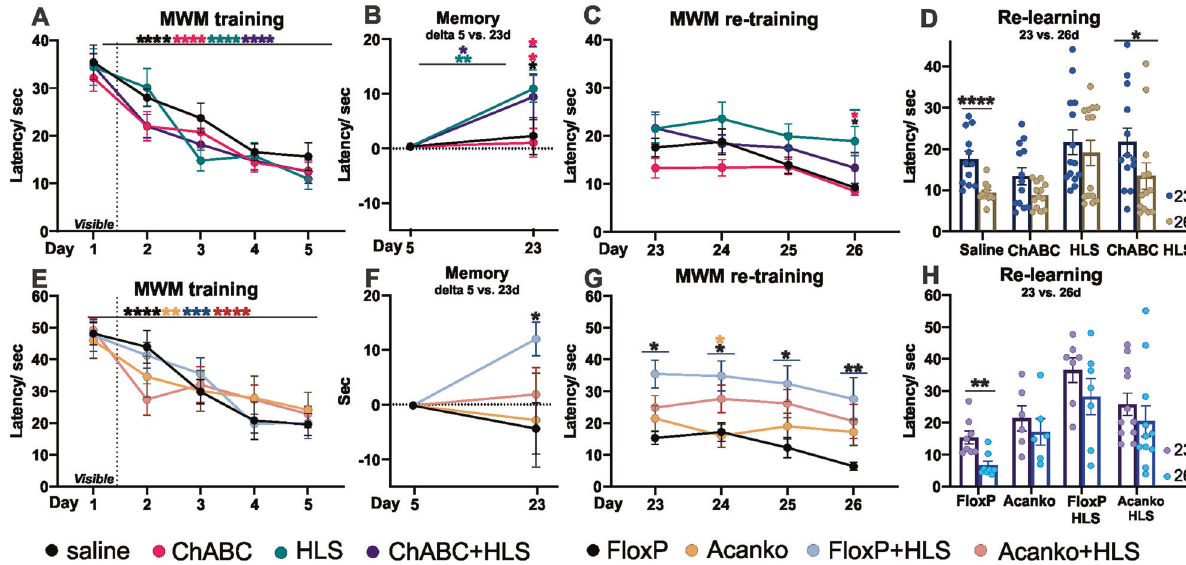
Fig. 4 Morris water maze; effects of PNN removal on memory before and after HLS. ChABC experiment ( A – D ) and Acan KO experiment ( E – H ). AAV- Cre to induce Acan KO was injected before initial training, ChABC after initial training. All, WT, fl oxP and Acan KO mice showed normal learning ( A (day 1 vs. day 5; TW -RM-ANOVA, Time: F (4,192) = 45.68, p < 0.0001, Group F (3,48) = 0.927 p = 0.44, E (TW -RM-ANOVA, Time: F (4,104) = 26, p < 0.0001, Group F (3,26) = 0.202 p = 0.99)). The training week was followed by ChABC injection ( A – D ) followed by HLS, then memory testing and training resumed on day 23. Hibernated animals showed a partial loss of memory, but not to the level of naïve animals ( B ). This loss had already recovered by day 23 in Acan KO + HLS mice ( F ). During the relearning phase ( C , D , G , H ), animals in the HLS ( C , G detail analysis D , H ) group did not show signi fi cant re-learning. However, animals treated with ChABC and HLS were fast relearners ( D , day 23 vs. 26, saline t = 4.751 p = 0.002, ChABC HLS, t = 2.885 p = 0.041). In the Acan KO + HLS animals ’ memory was not lost during the HLS period, suggesting rapid relearning during this period ( F ). Generally, FloxP HLS animals showed worsened performance in re-training week in comparison to fl oxP control, but no statistical difference between Acan KO and Acan KO HLS was found (re-training, TW-RM-ANOVA, Group: F (3, 26) = 6.155 p = 0.0026, FloxP vs. FloxP HLS q = 5.737 p = 0.0021, Acan KO vs. Acan KO HLS q = 1.943, p = 0.526). Signi fi cance * p < 0.05, ** p < 0.01, *** p < 0.001. Statistics Table S6. (this Figure saline n = 13, HLS n = 14, ChABC n = 13, ChABC HLS n = 14, FloxP n = 8,